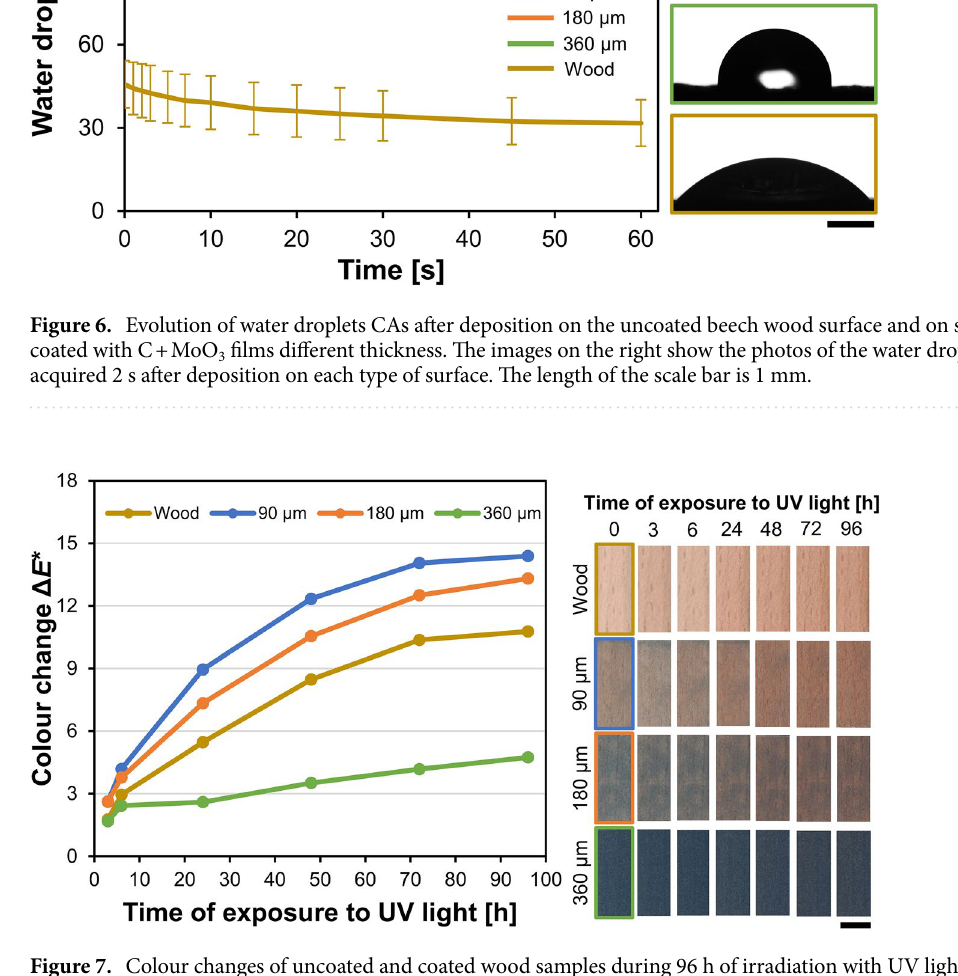
Figure 7. Colour changes of uncoated and coated wood samples during 96 h of irradiation with UV light. The length of the scale bar is 10